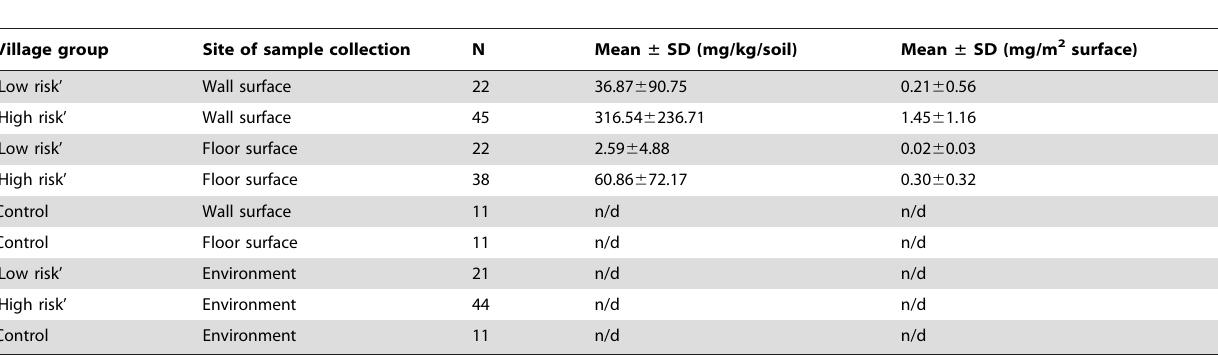
Table 3. Concentration of DDT residue in mg/kg of soil and mg/m 2 surface area in soil samples from wall and floor surfaces of houses and the environment among seven villages in Gilgel-Gibe area, southwestern Ethiopia.